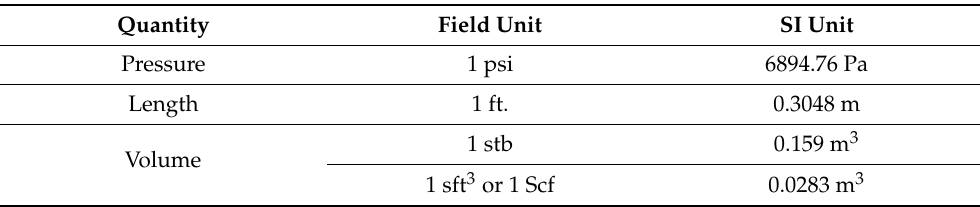
Table A1. Conversion